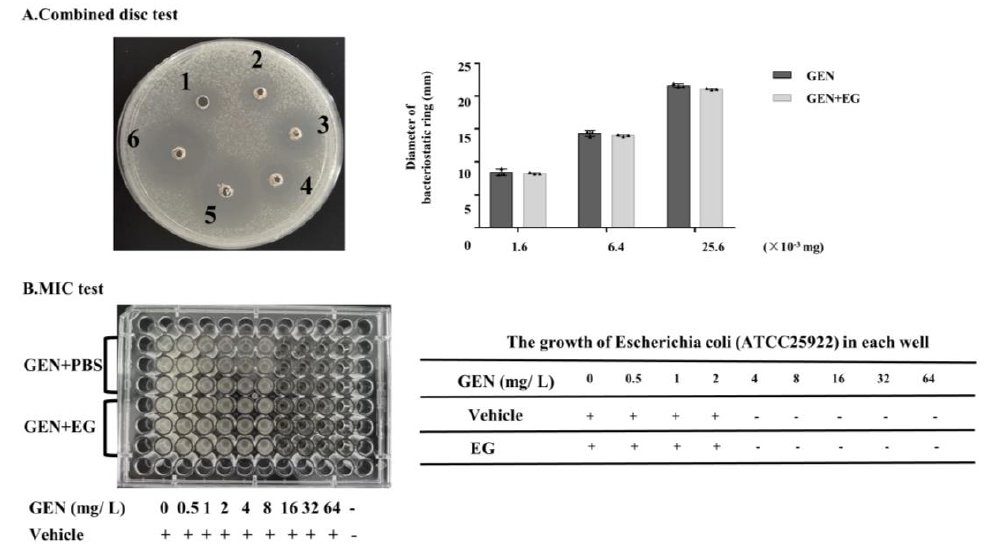
Figure 8. The effect of EG on the antimicrobial activity of GEN. ( A ) Combined disc test was used to detect the effect of EG (25 μM) on the inhibitory ring of GEN against Escherichia coli ( E. coli ). ( B ) A minimal inhibitory concentration (MIC) test was used to analyse the impact of EG (25 μM) on the antibacterial activity of GEN to E. coli in the liquid culture medium. A “+” indicates bacterial growth and a “−” indicates no bacterial growth. In vitro data was presented as the mean ± SEM of three independent experiments.